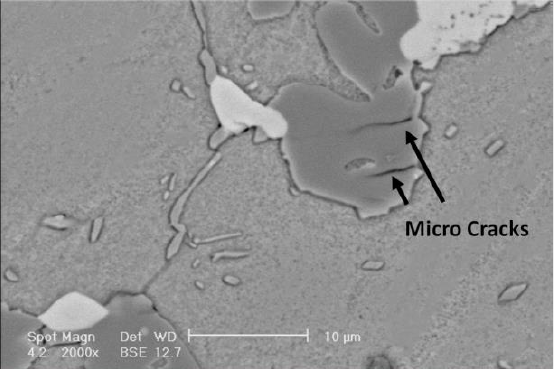
Figure 6. SEM images of microstructure of failed tube (Tube A). Micro cracks formed within chromium carbide particles are indicated with the arrows.